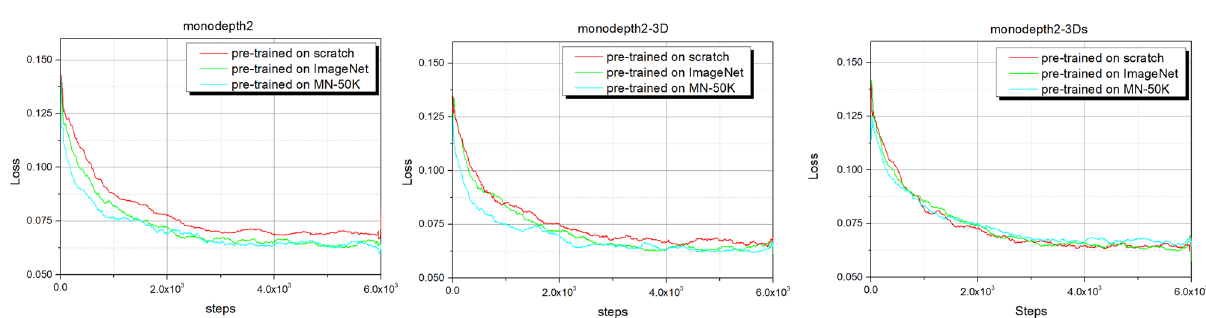
Figure 9. Fine-tuning curves of three test models on FPV.